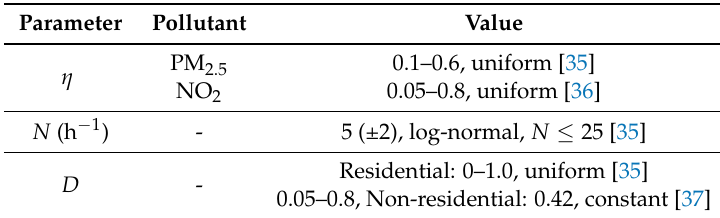
Table 2. Values of air HVAC system related parameters.